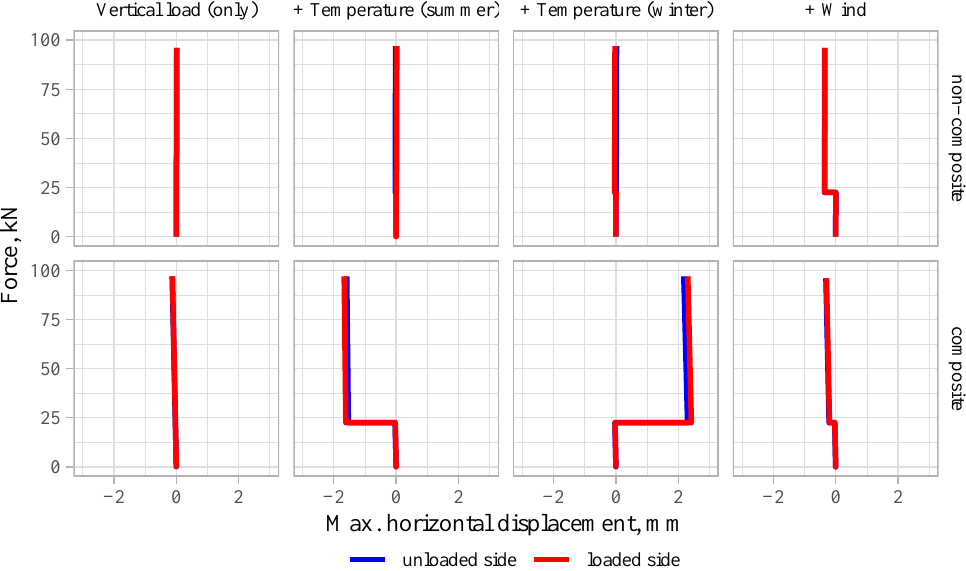
Figure 20. Lateral displacement of the wythes under different load combinations in the range of design